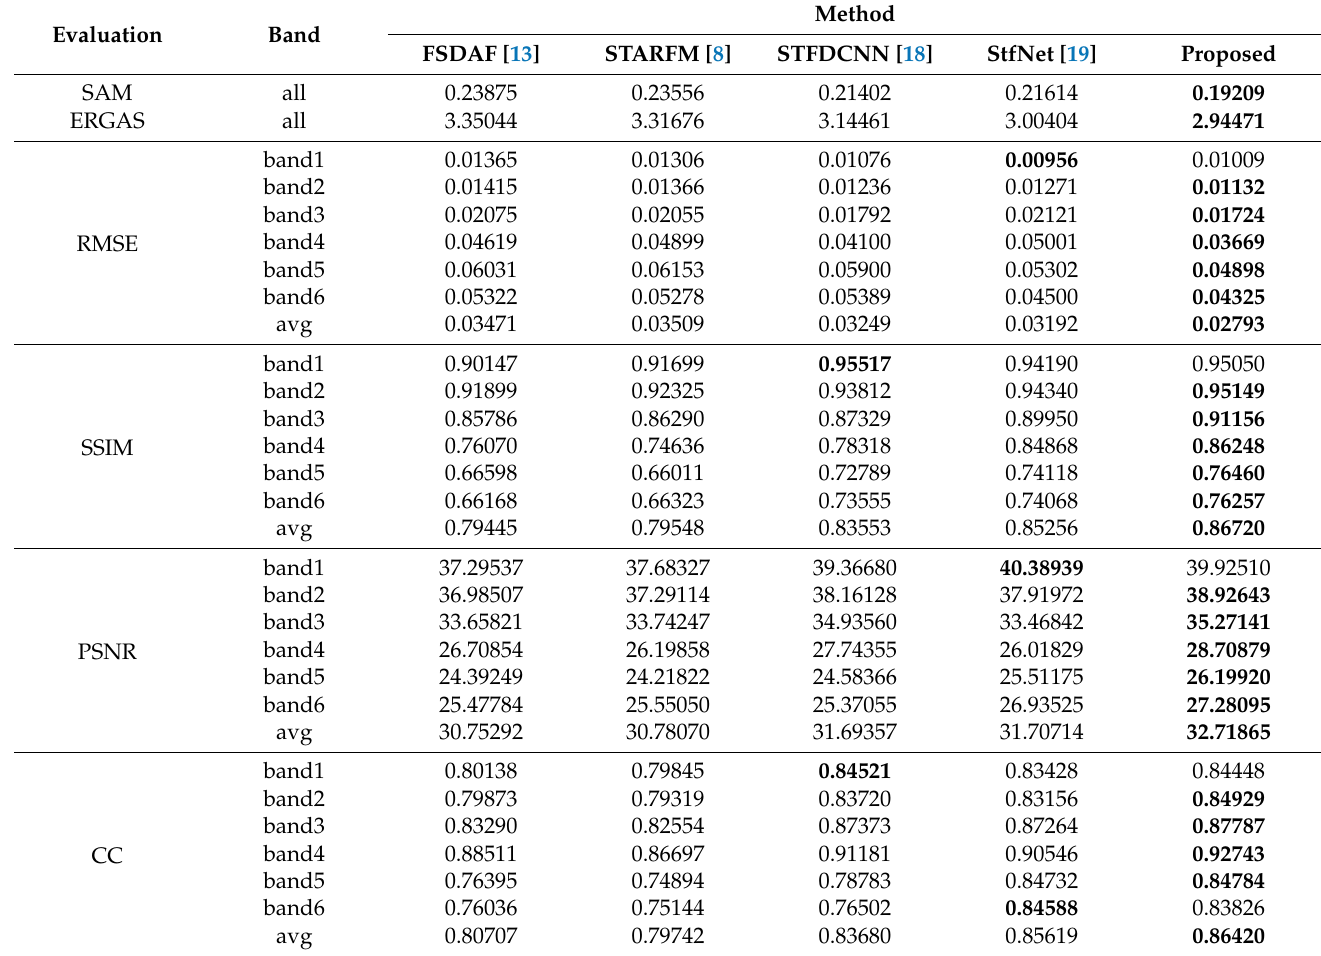
Table 4 lists the evaluation results of various methods on the AHB dataset. It can be seen that, except for some fluctuations in the evaluation results for individual bands, our method achieves the best values in the rest of the evaluation results. Table 2. Quantitative assessment of different spatiotemporal fusion methods for the CIA [31]